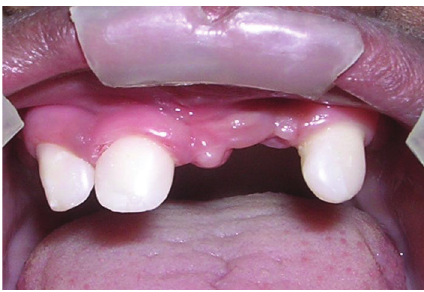
Figure 5: Composite restorations of 11, 12, and 23.